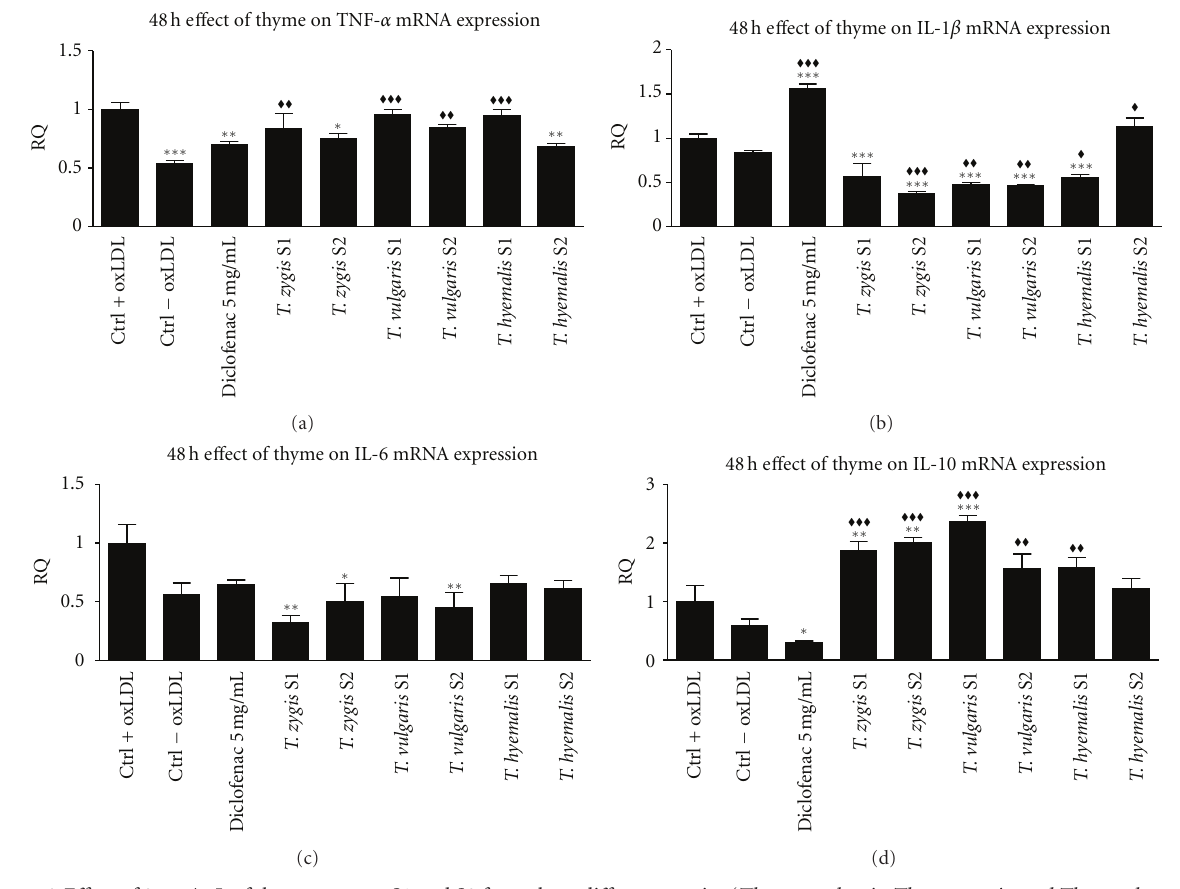
Figure 6: E ff ect of 25 μ g/mL of thyme extracts S1 and S2 from three di ff erent species ( Thymus vulgaris, Thymus zygis, and Thymus hyemalis ) on the relative quantification (RQ) of TNF- α gene expression (a), IL-1 β (b), IL-6 (c), and IL-10 (d) on macrophage-THP-1 cells. Cells were di ff erentiated with (PMA) 100 ng/mL for 24h and afterwards treated as described in Section 3 for 48 hours. Data represent means ± SEM calculated from six independent experiments with 3 replications for each treatment. Statistic Dunnett’s multiple comparison test versus Ctrl +oxLDL signification is represented by ∗ P values less than 0.05, significant; ∗∗ P values less than 0.01, very significant; and ∗∗∗ P values less than 0.001, extremely significant. Statistic Bonferroni multiple comparison test versus Ctrl − oxLDL signification is represented by (cid:3)(cid:3) P values less than 0.01, very significant; and (cid:3)(cid:3)(cid:3) P values less than 0.001, extremely significant. One group was treated with a small concentration of diclofenac (5 μ g/mL) as positive standard